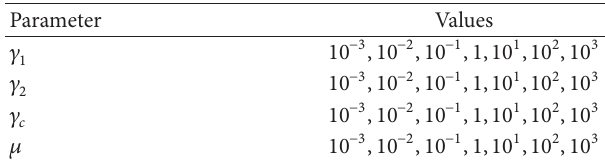
Table 1: A finite grid of parameter values. We find the best performance of each online co-regularization algorithm on this finite